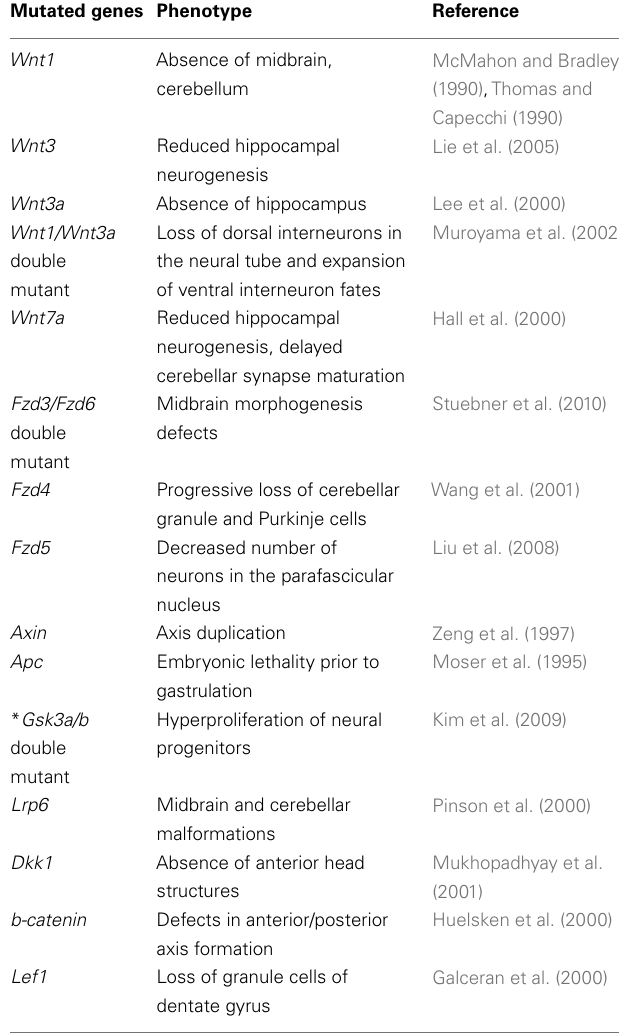
Table 1 |Wnt pathway components are essential for neural